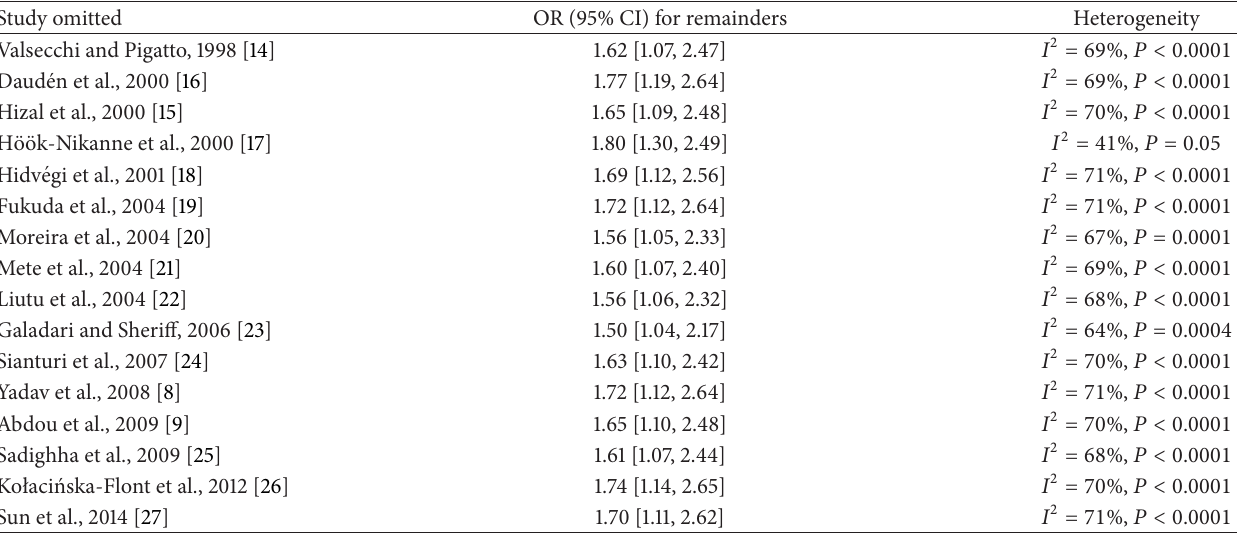
Table 3: Sensitivity analysis after each study was excluded by